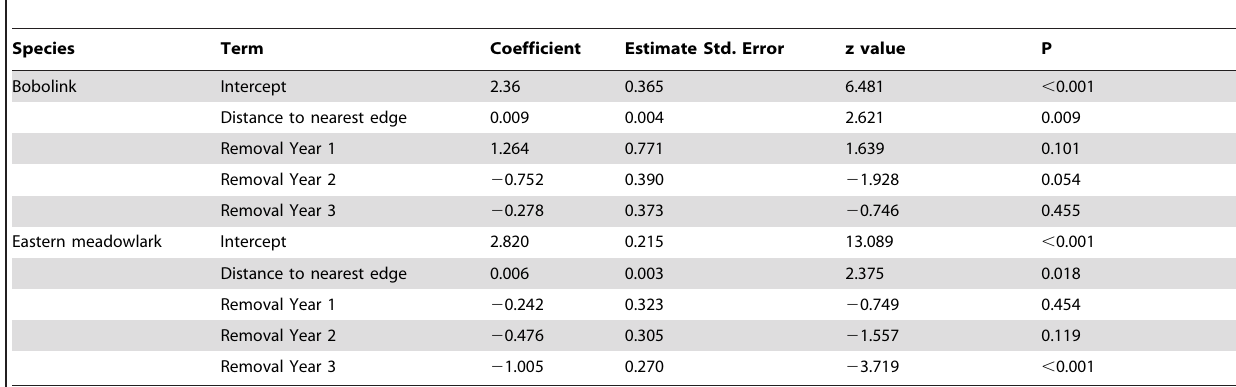
Table 5. Coefficients for the minimum AICc models for bobolink and Eastern meadowlark from Table